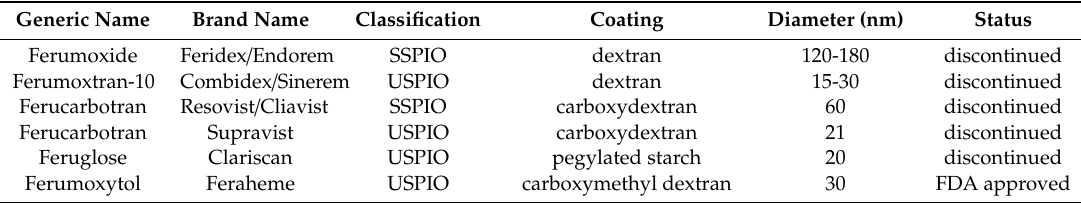
Figure 2. Comparison of size between ultra-small SPIO (USPIO) and SPIO (upper), and exosome and microvesicles (lower). [Unpublished figure]. Table 2. Clinical SPIO (cited from [61] ).